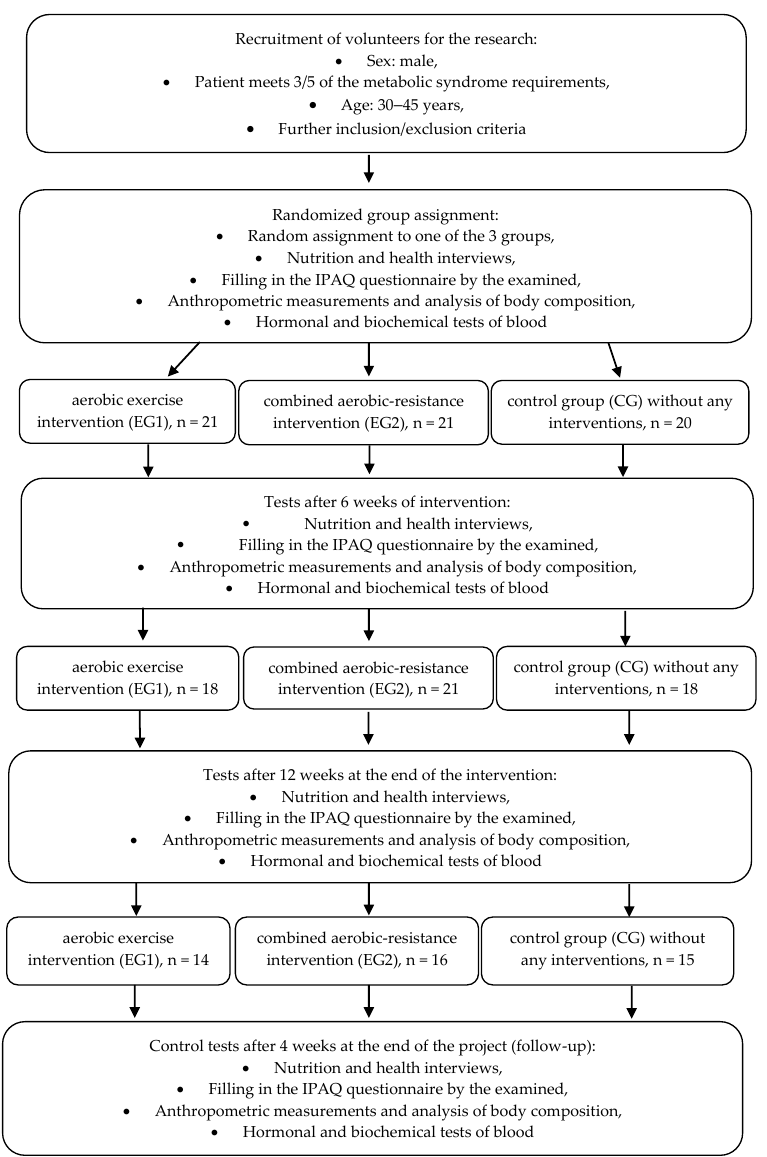
Figure 1. The course of the study.